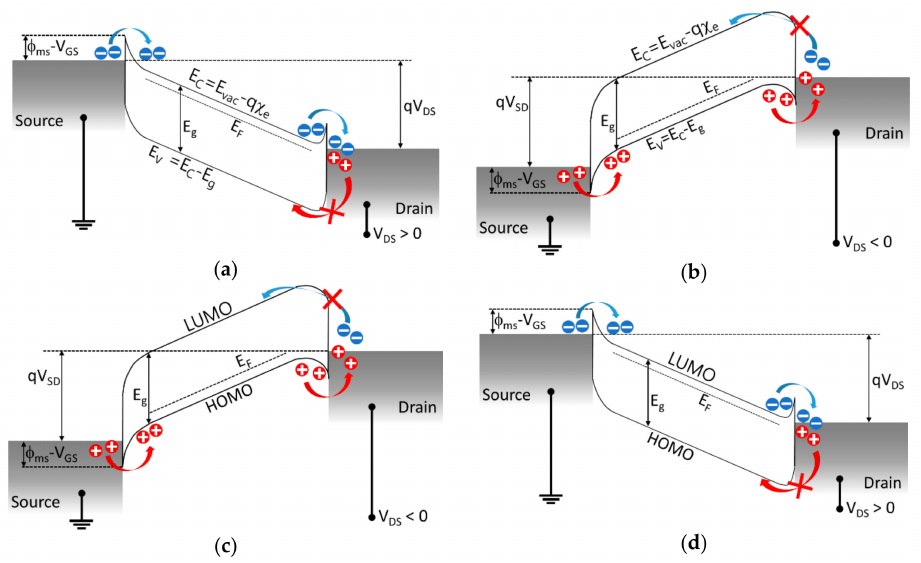
Figure 2. Energy band diagram along the channel from source to drain of the TFT, which is in on-state. ( a ) Inorganic n-channel TFT case with positive V GS and V DS . The electrons are traveling well while the holes are facing the high barrier. ( b ) Inorganic p-channel TFT case with negative V GS and V DS . The holes transport through the channel, but the electrons are blocked by the high barrier. ( c ) Organic p-channel TFT case with negative V GS and V DS . Only the hole conduction is established as well as the inorganic p-channel TFT case. ( d ) Organic n-channel TFT case with positive V GS and V DS . Only the electrons travel along the channel; likewise, the case of inorganic n-channel